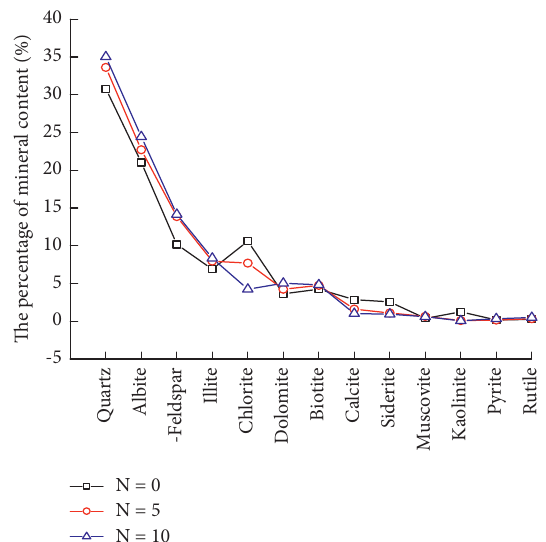
Figure 3: Percent change in the mineral content of weakly cemented sandstone under different numbers of dry-wet cycles.